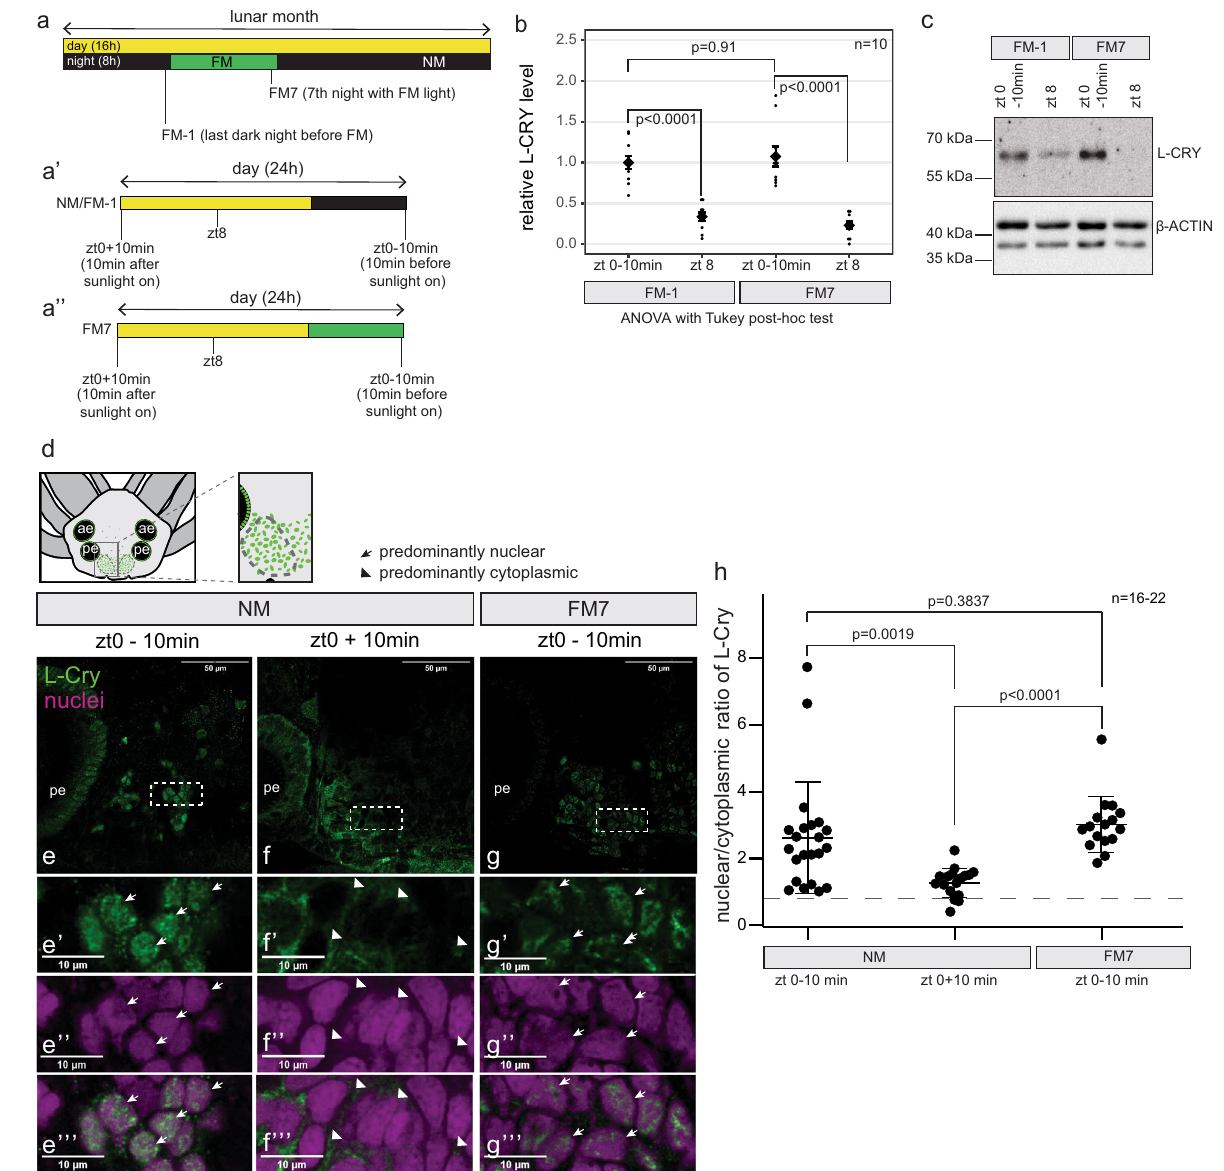
Fig.6|Naturalisticmoon-andsunlightimpactdifferentlyonL-Crylocalization and levels. a , a ′ , a ″ Overview of sampling timepoints. 16h day (light) and 8h night (dark or moonlight) per 24h, with 8 nights of moonlight per month. NM and FM-1 have the same light regime, but are named differently for accuracyasthey refer to different days relative to the lunar month. b relative L-Cry levels at indicated timepoints, as determined by western Blot. Individual data points as well as mean±SEMareshown.Ordinaryone-wayANOVA: p <0.0001;adjusted p -valuesof Tukey ’ s multiple comparison test: FM-1 zt0 – 10 min vs FM-1 zt 8: p <0.0001, FM7 zt0 – 10minvsFM7zt8: p <0.0001,FM-1zt0 – 10minvsFM7zt0 – 10min: p =0.9141. c Representative Western Blot used for quanti fi cation in ( b ), see Supplementary Fig.7forallother.Inaddition,inthecontextoffurtherinvestigationssuchWestern blots of identical or similar conditions were performed completely independently meanwhilemorethanthreetimeswithhighlyconsistentresults. d P.dumerilii head. Dashed ovals designate the oval-shaped posterior domains between the posterior eyes. Green dots: L-Cry+ cells. ae, anterior eye; pe, posterior eye. e – g Confocal single layer (1.28 µ m) images of worm heads stained with anti-L-Cry antibody